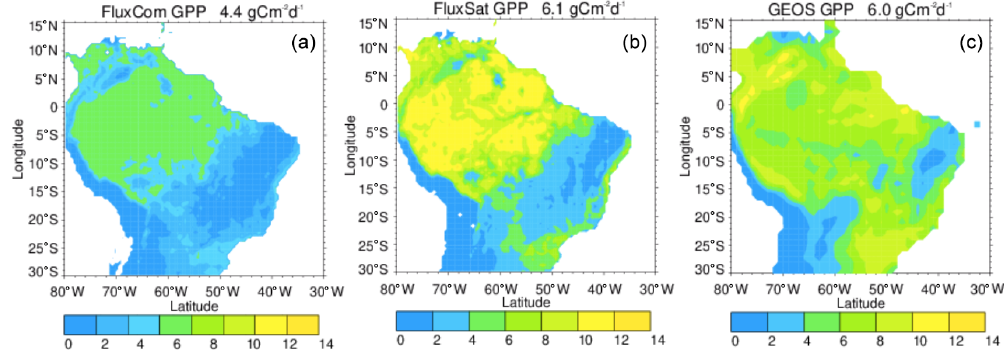
Figure 7. The multiyear (2010–2015) August–October mean Amazon GPP from (a) FluxCom (Jung et al., 2020), (b) FluxSat (Joiner et al., 2018), and (c) the GEOS ecosystem simulation with units of gCm − 2 d − 1 . The Amazon regional average value is shown at the top.